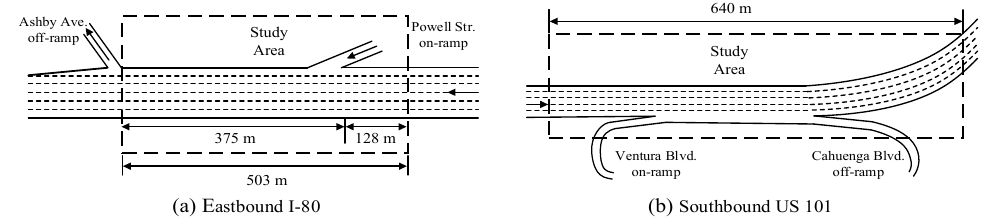
Figure 1. Freeway sites where NGSIM vehicle trajectory data are obtained.